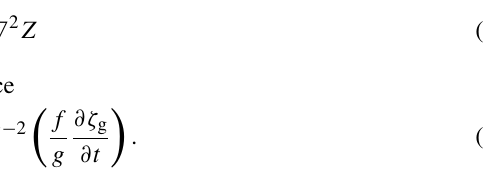
Table 1. List of mathematical symbols. c p = 1004Jkg − 1 specific heat of dry air at constant volume f Coriolis parameter F forcing in the omega equation F friction force per unit mass g = 9.81ms − 2 gravitational acceleration k unit vector along the vertical axis L linear operator in the left-hand side of the omega equation p pressure Q diabatic heating rate per mass stability parameter in pressure coordinates temperature horizontal wind vector geostrophic wind vector relaxation coefficient hydrostatic stability isobaric mean of hydrostatic stability vertical component of relative vorticity relative vorticity of geostrophic wind relative vorticity of ageostrophic wind isobaric vertical